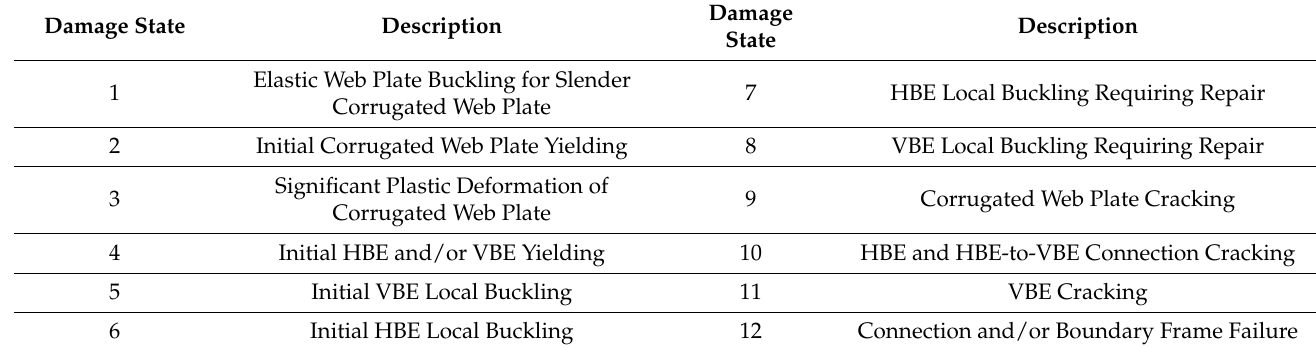
Table 2. Damage states.